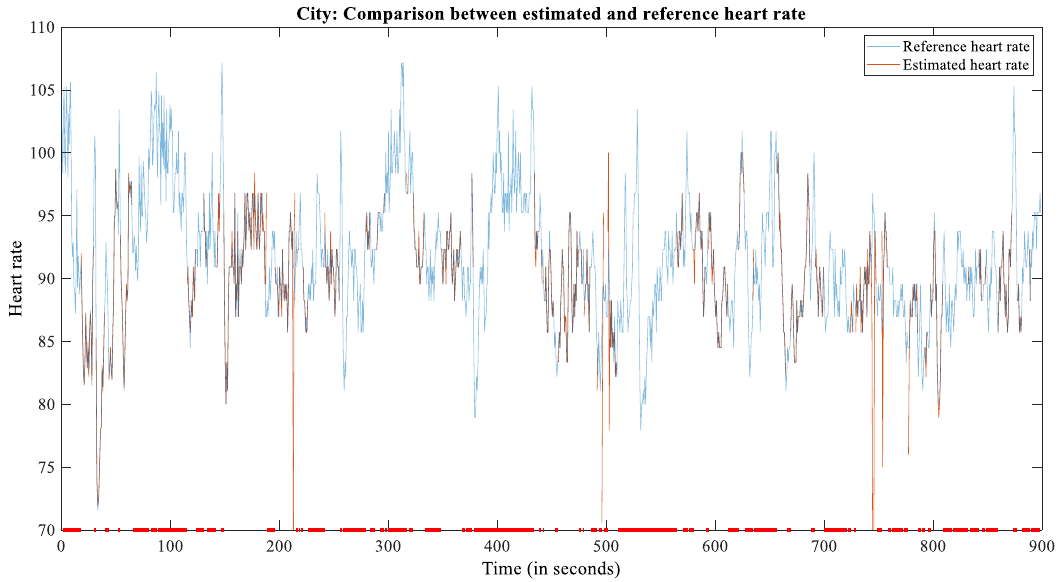
Figure 6. The plot of reference and estimated HR for subject 2209 during the city scenario.